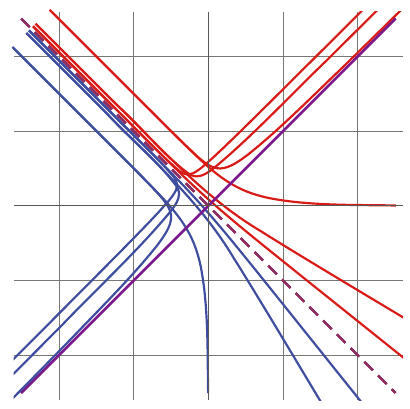
, ≠ c 0 , = ± ϵ 1 v − ε e c v +